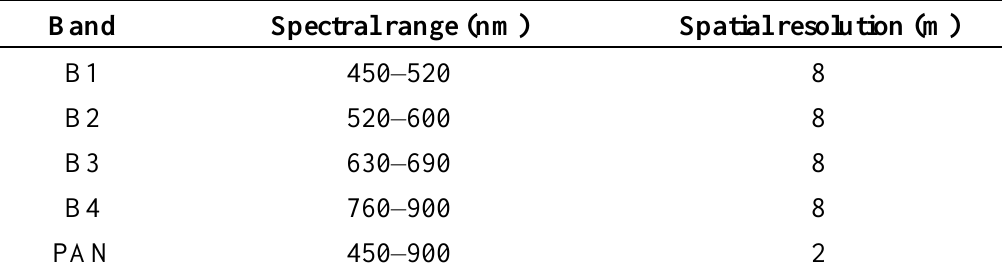
Table 1. Spectral and spatial characteristics of the remote sensing instrument (RSI) onboard the FORMOSAT-2